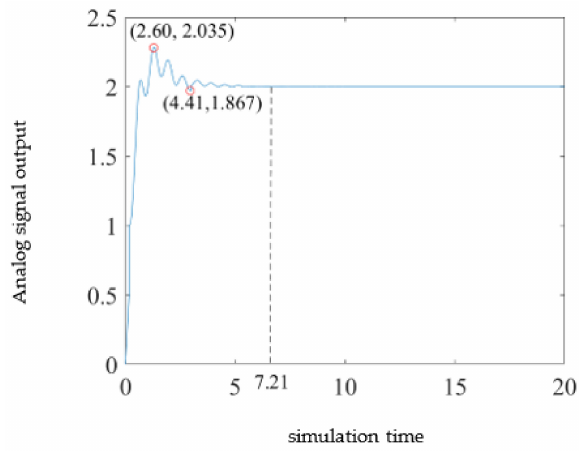
Figure 11. Simulation waveform of fuzzy PID control model.